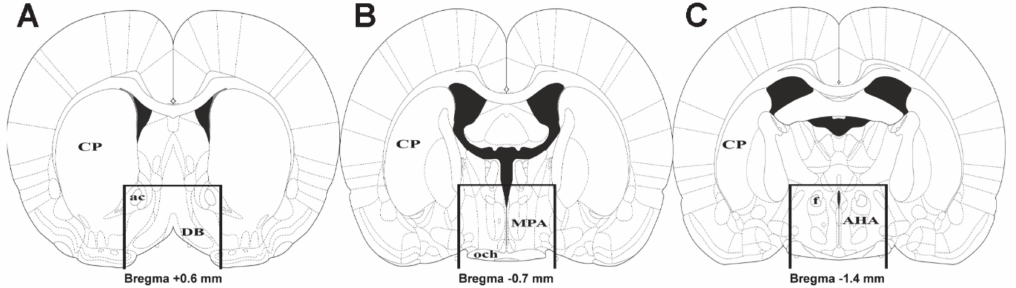
Figure 9. Position of the dissected tissue. The three drawings represent the level of the anterior cut ( A ), the middle level ( B ), and the posterior cut ( C ) in the coronal plane. Bars on the drawing represent vertical and horizontal cuts. Abbreviations: ac = anterior commissure, AHA = anterior hypothalamic area, CP = caudate putamen, DB = diagonal band of Broca, MPA = medial preoptic area, och = optic